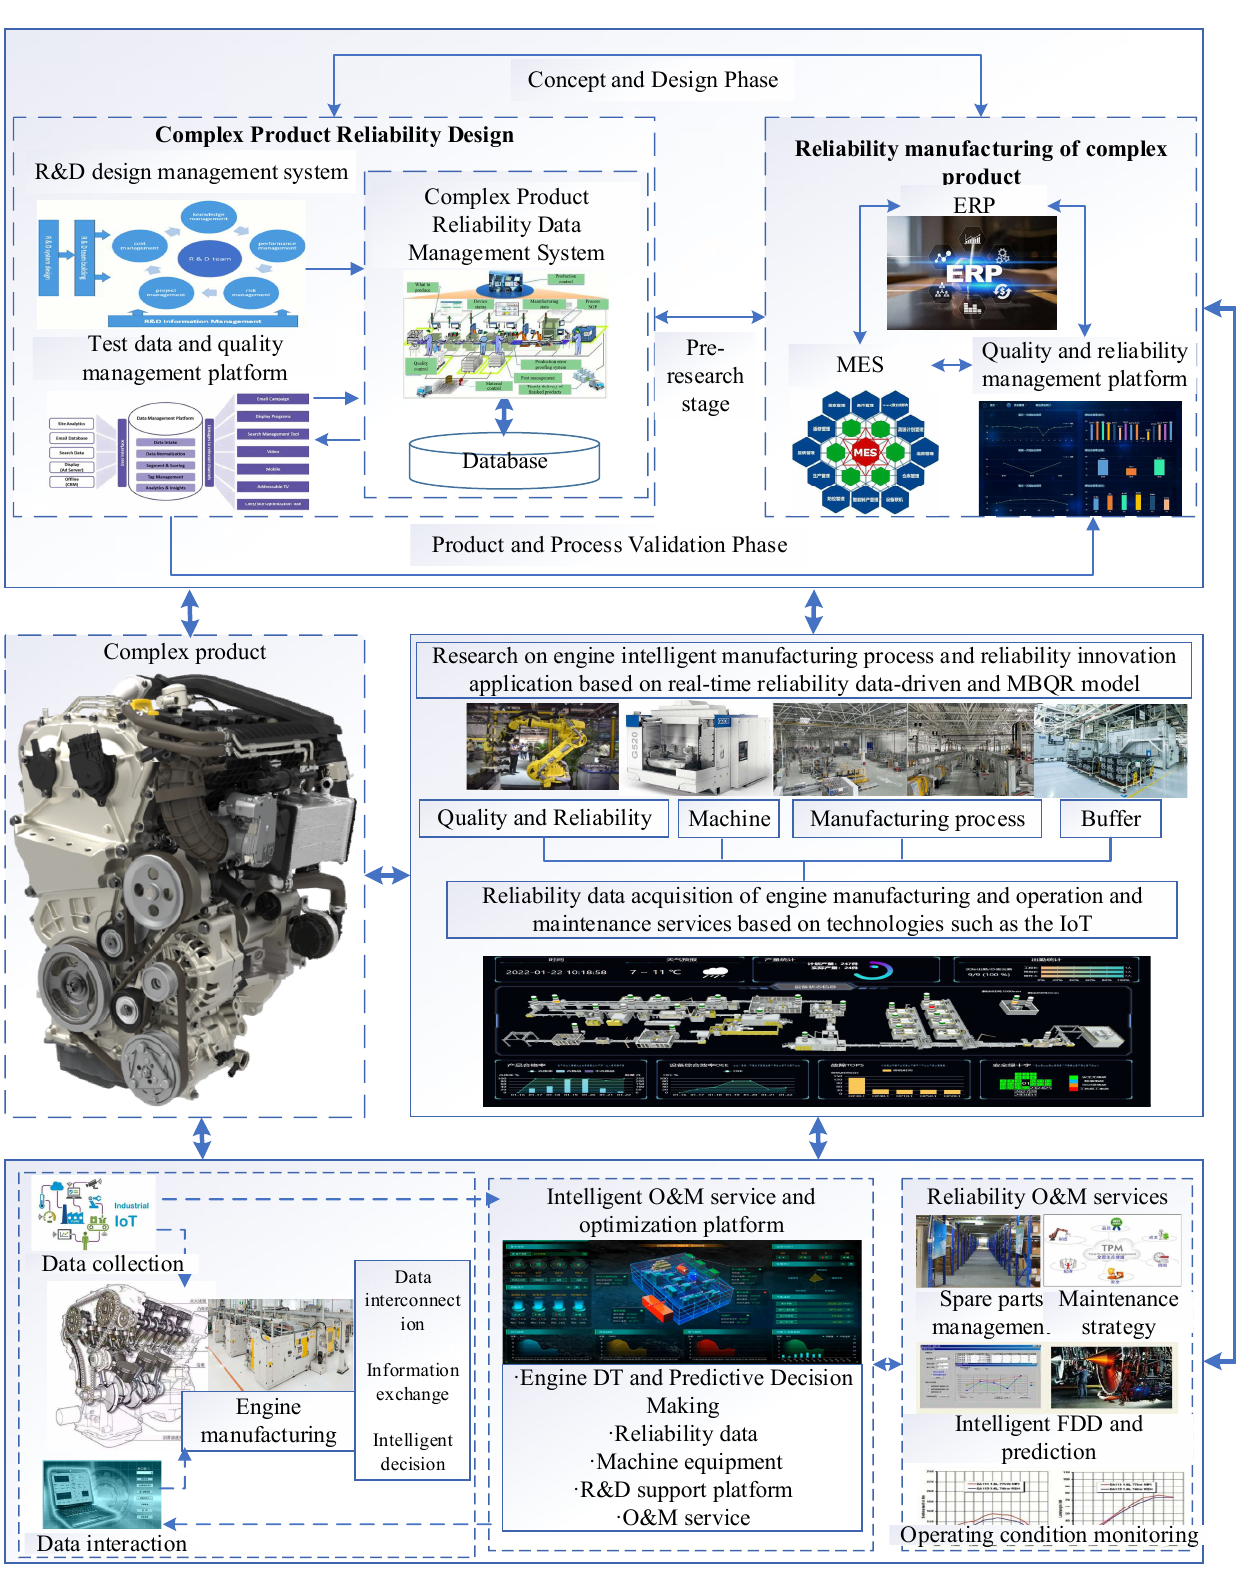
Figure 5. Case study of engine DMS integration based on reliability data drive.